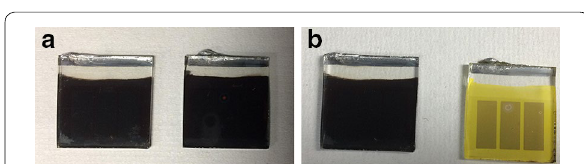
Fig. 4 a I – V curves and b IPCE spectra measured of fabricated all inorganic perovskite solar cell using the ZnO nanoparticles ETL hav‑ ing diameter of 25 nm